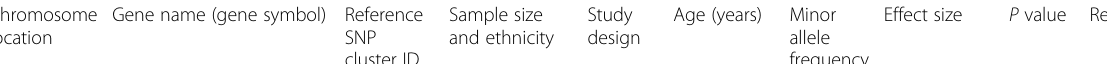
Table 2 Candidate gene association studies examining the association of SNPs with vitamin B12 concentrations. Candidate gene association studies testing the association between SNPs and vitamin B12 concentrations. The chromosome location, gene name, reference SNP cluster ID, sample size and ethnicity, study design, mean age, observed frequency of the minor allele in the population, effect size and P value are shown in the table. The order of SNPs reflects the order of the chromosome location